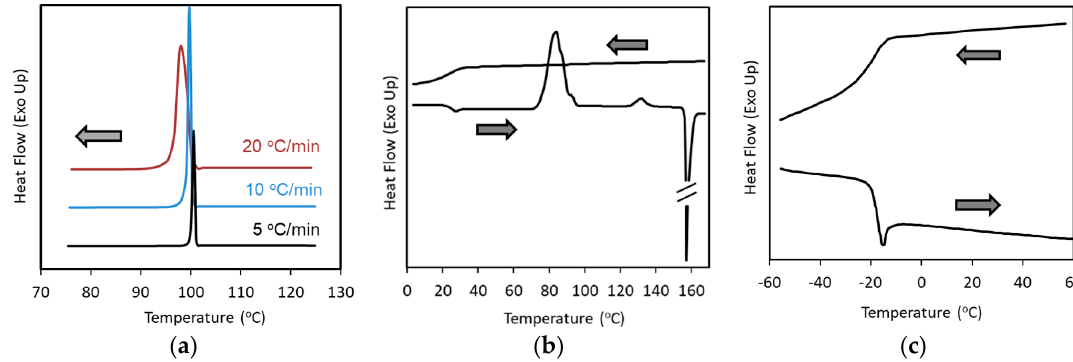
Figure 2. Examples of cooling/reheating differential scanning calorimetry (DSC) curves from the melt: ( a ) cooling curves of haloperidol (Class 1) at various cooling rates, as indicated in the figure; ( b ) cooling/reheating curves of acetaminophen (Class 2); and ( c ) cooling/reheating curves of fenofibrate (Class 3).